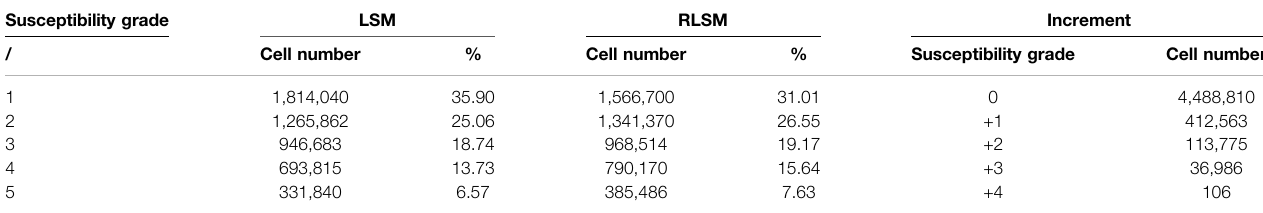
TABLE 4 | Comparison of landslide susceptibility grades obtained from the FR-RF model and RLSM. Susceptibility